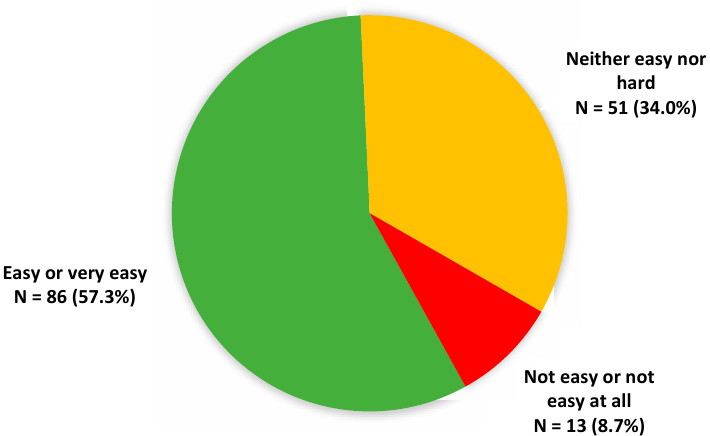
Figure 1. Past experience of fasting in aged respondents.